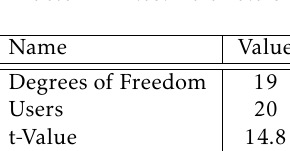
Table 4. T-test Parameters